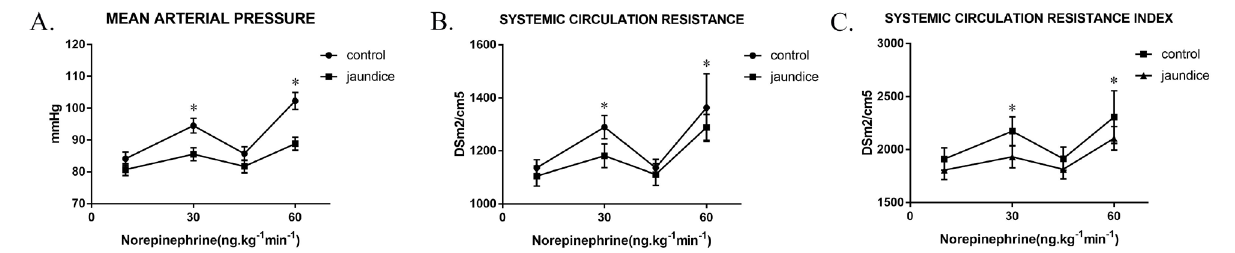
Figure 1 - Vascular reactivity after agent administration. A. Measured MAP values in OJ and non-OJ patients (P=0.013, two-way ANOVA with post hoc Bonferroni correction, N=10 in Jaundice group while 9 in Control). B. Measured SVR in OJ and non-OJ patients (P=0.08, two-way ANOVA with post hoc Bonferroni correction, N=10 in Jaundice group while 9 in Control). C. Measured SVRI in OJ and non-OJ patients (P=0.11, two-way ANOVA with post hoc Bonferroni correction, N=10 in Jaundice group while 9 in Control).